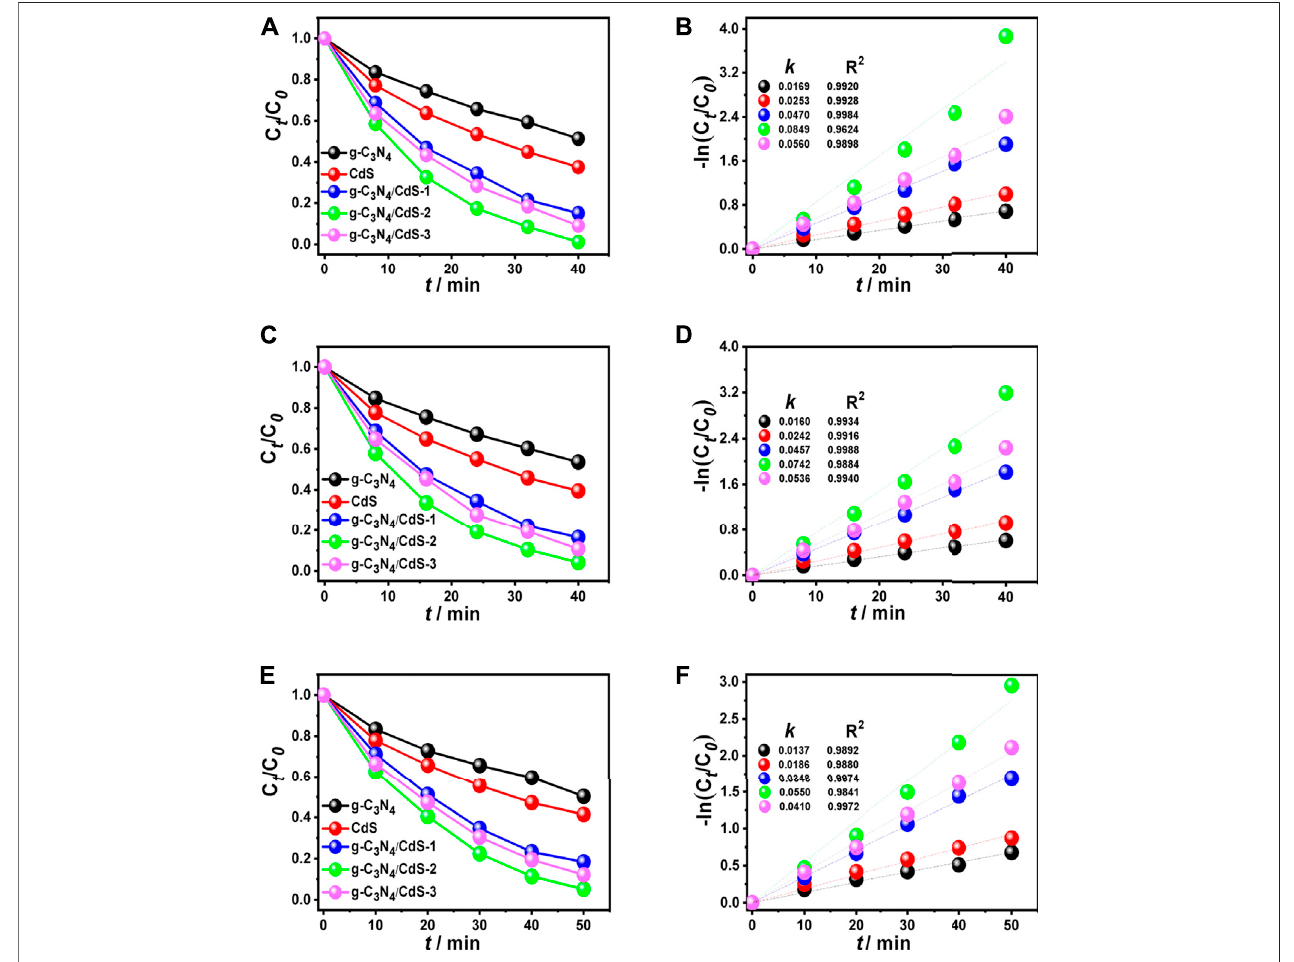
FIGURE 5 | Photocatalytic degradation under visible light irradiation of (A) RhB, (C) MB, and (E) phenol, and (B,D,F) corresponding apparent reaction rates using g-C 3 N 4 , CdS, and g-C 3 N 4 /CdS